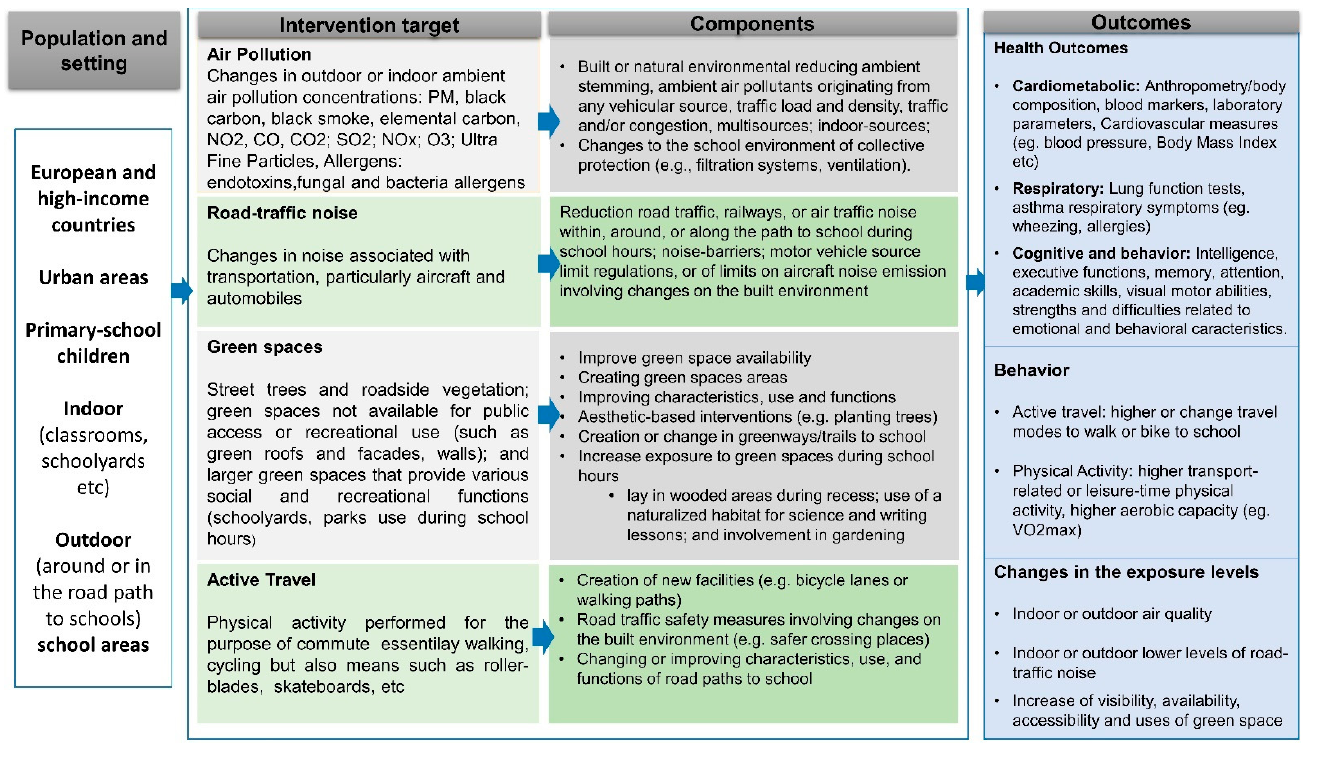
Figure 1. PICO-driven question scheme.